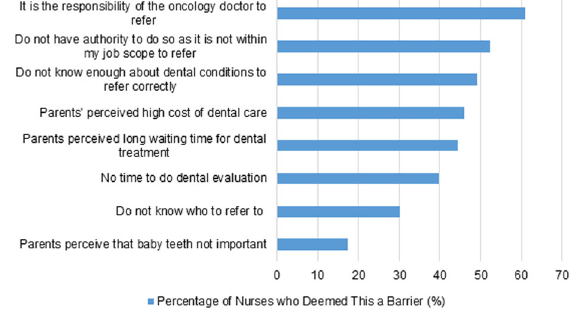
Fig. 3 Responses to “ Concerns preventing you from referring your patients to see a dentist ”